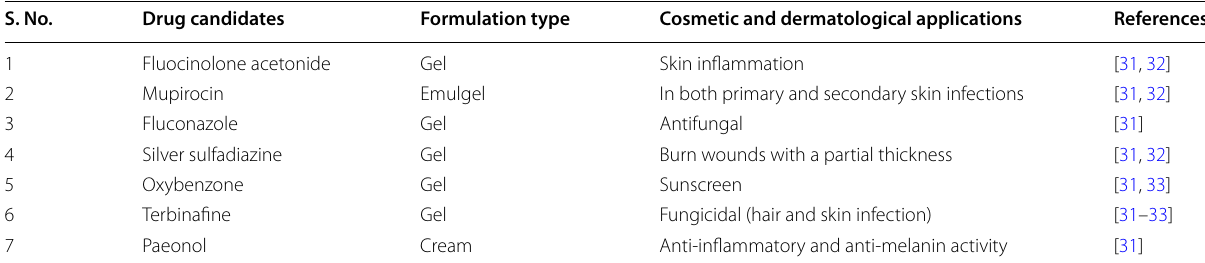
Table 4 Drug candidates explored using microsponge delivery systems for dermatological and cosmetic applications S.